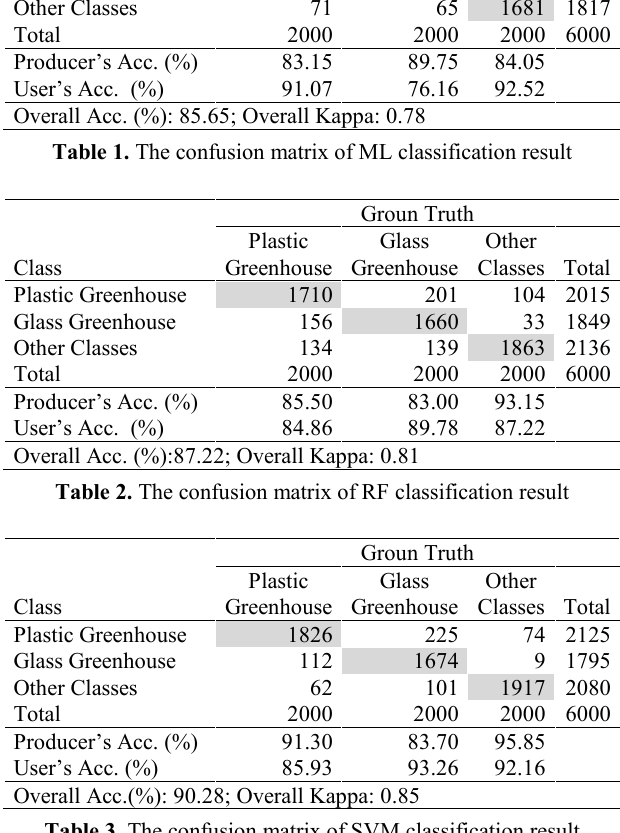
Table 3. The confusion matrix of SVM classification result